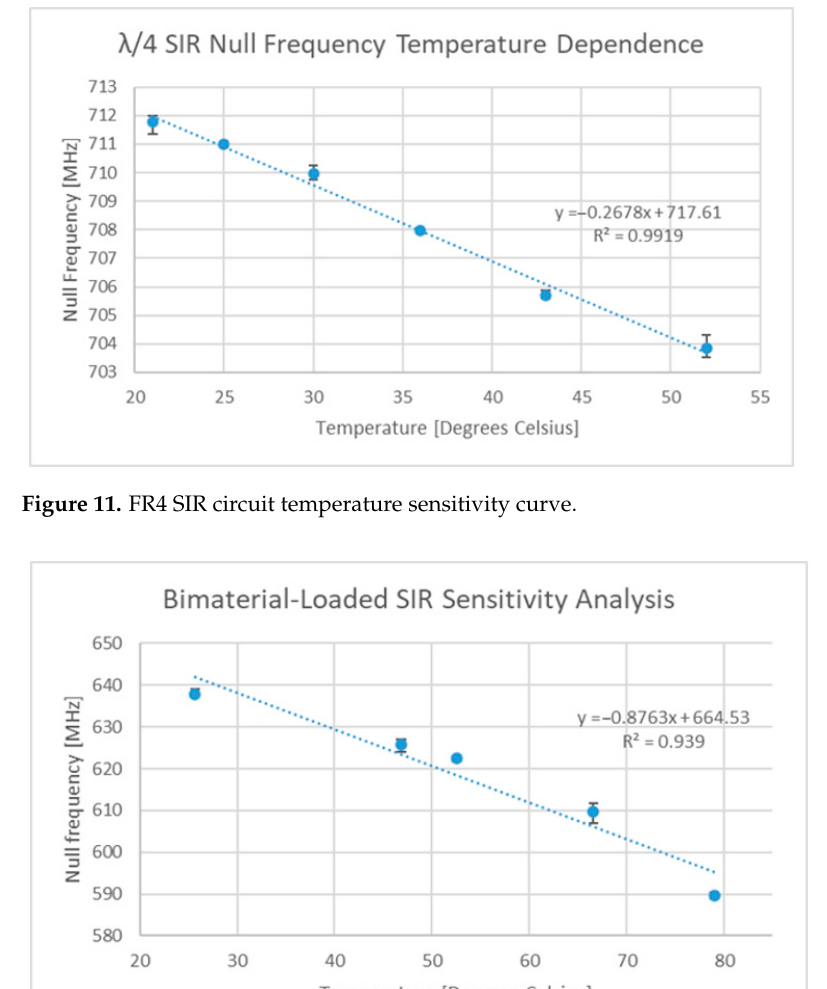
Figure 10. Latex V1 transverse strain cross ‐ sensitivity curve.